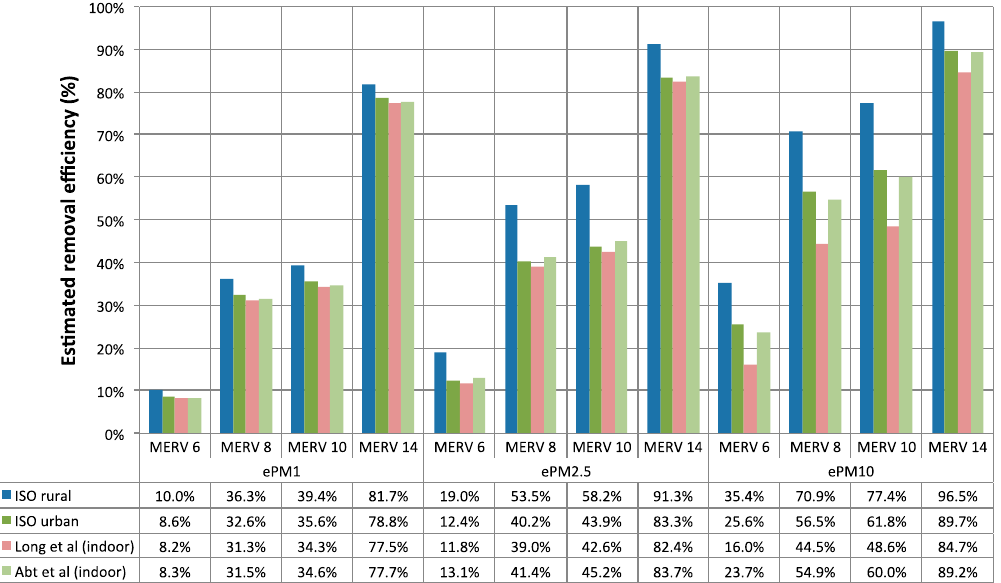
Figure 9. Estimates of e PM 1 , e PM 2.5 , and e PM 10 for four HVAC filters made using the ISO 16890 ambient aerosol distributions (assuming filtration of 100% outdoor air), and two indoor aerosol distributions for homes in Boston, MA, US from Abt et al. (2000) [50] and Long et al. (2001) [51].